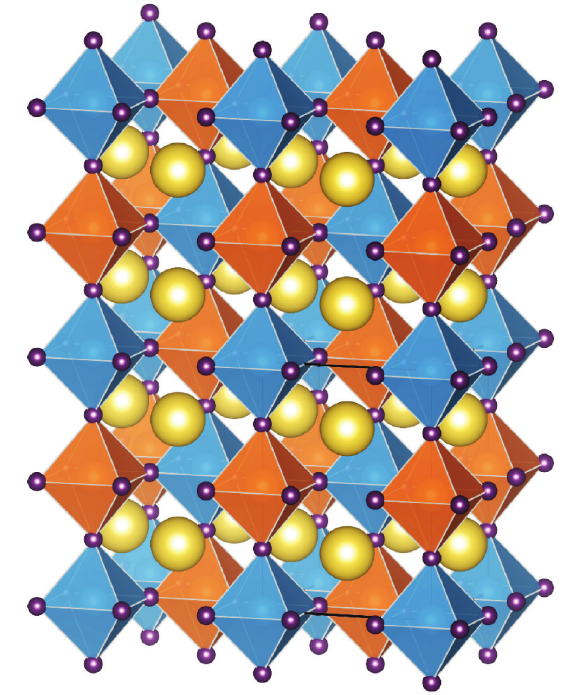
Figure 1. Perfect SFMO crystal lattice (Sr ions are marked in yellow, Fe ions in blue, Mo ions in orange and O ions in purple). The image was obtained by means of VESTA software